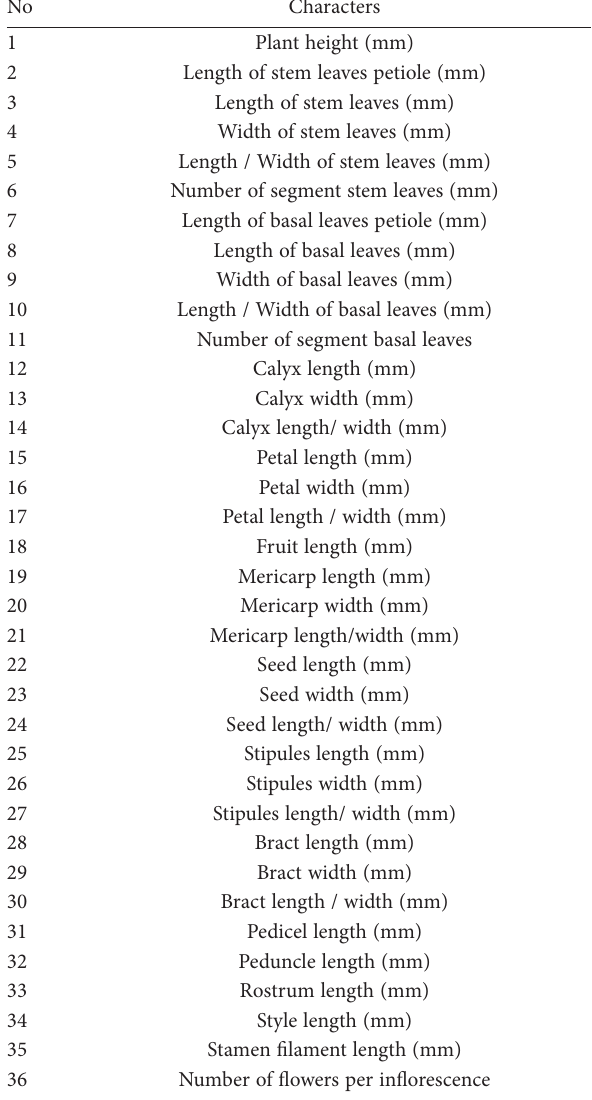
Table 1. Alcea species and populations, their localities and voucher numbers.